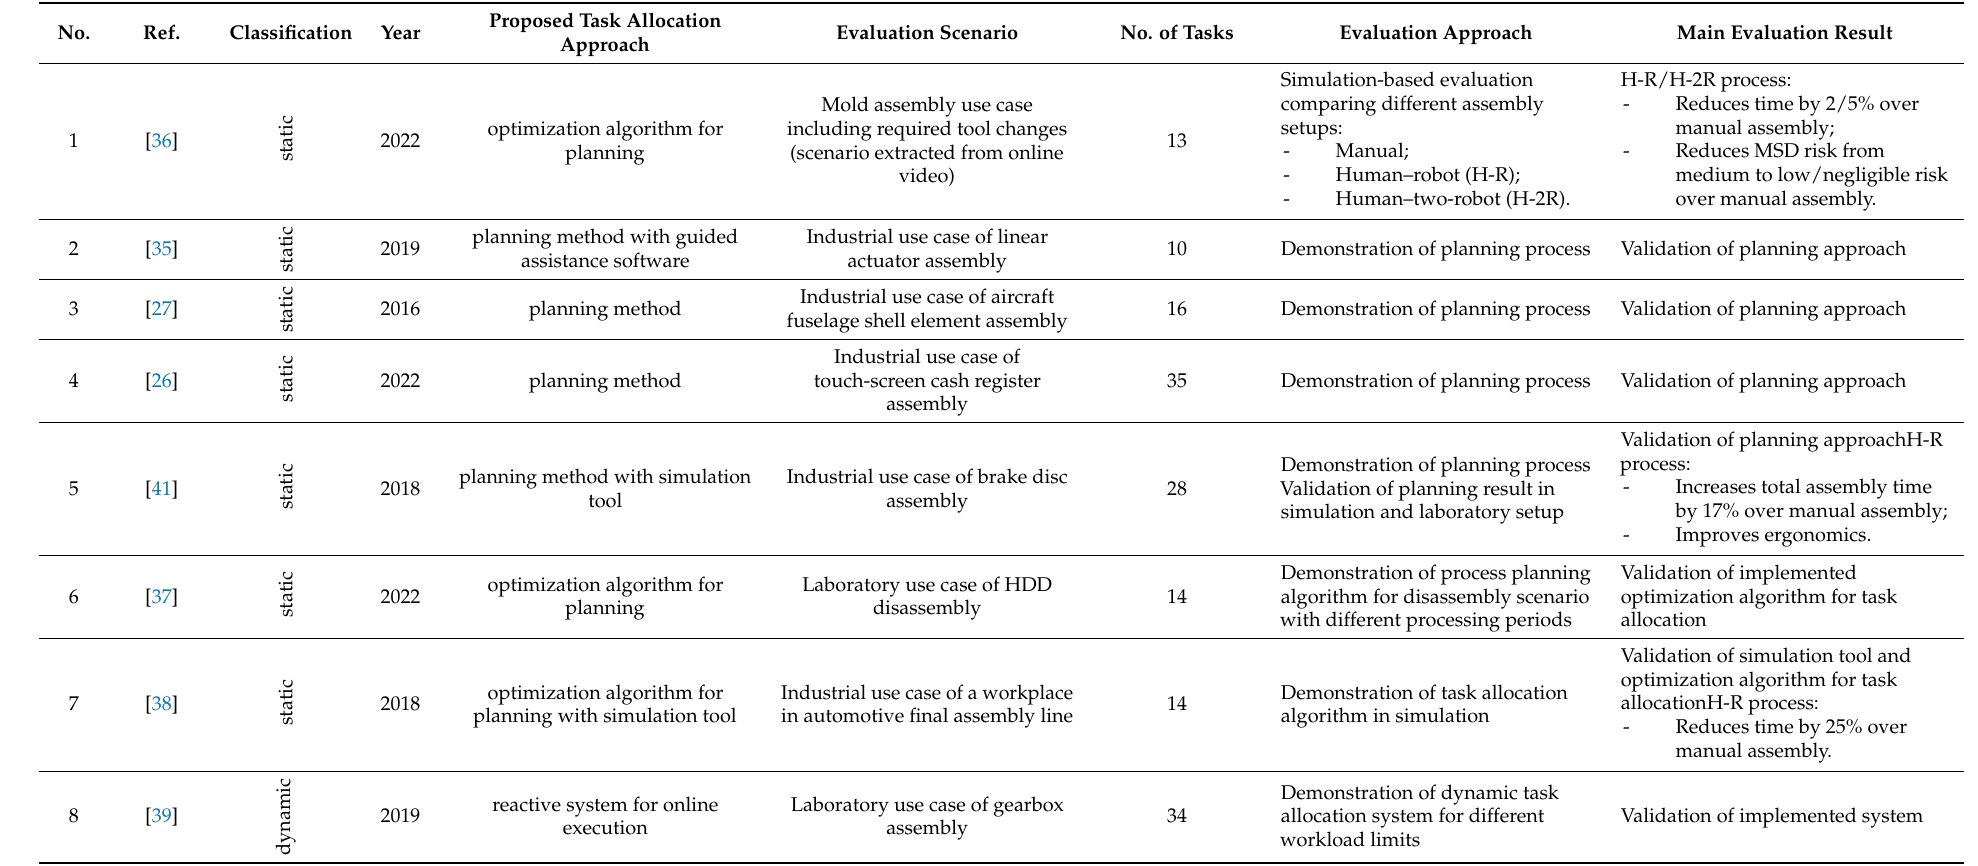
Table A1. Overview of related task allocation methods and their evaluation approaches. Task allocation methods that have been evaluated in user studies are highlighted in light